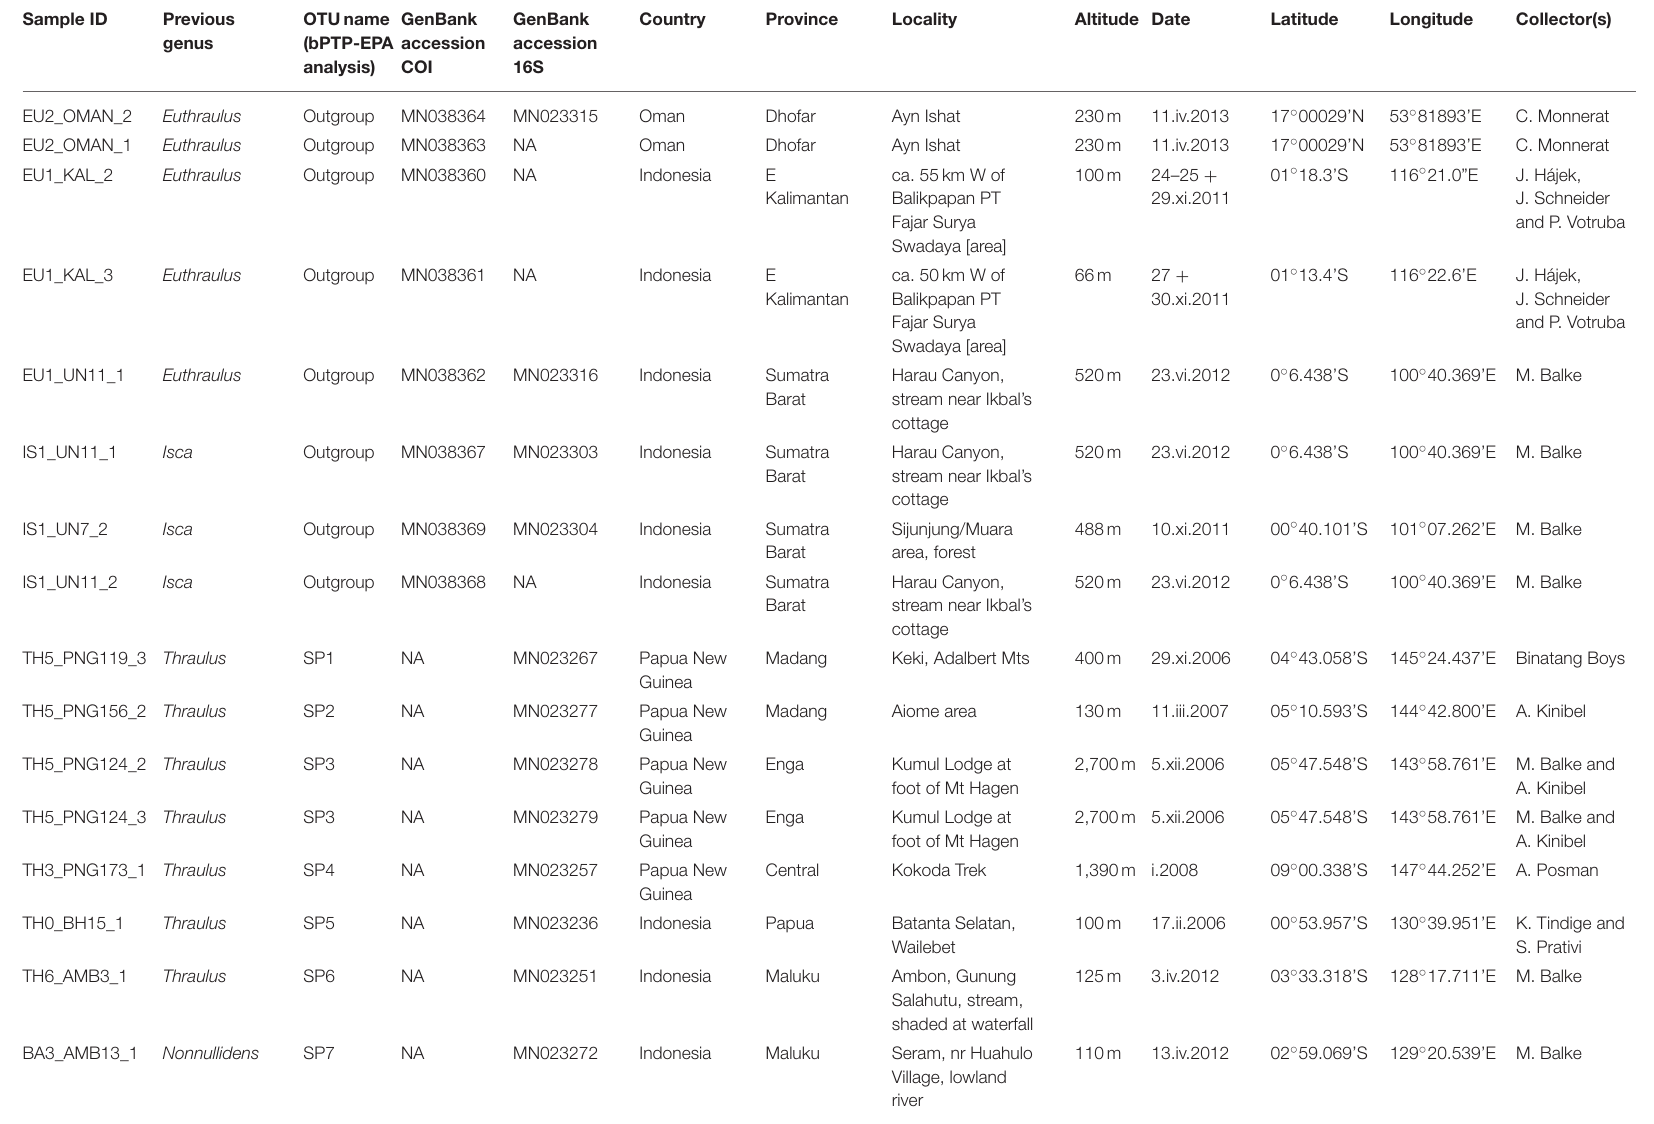
TABLE 1 | Sampling information on specimens used in this study, with lineages putatively associated with species to be described (M. Sartori, unpublished